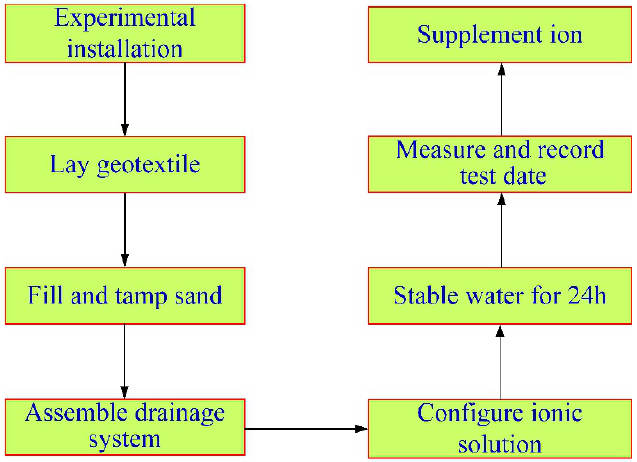
Figure 5. Schematic diagram of experimental steps.